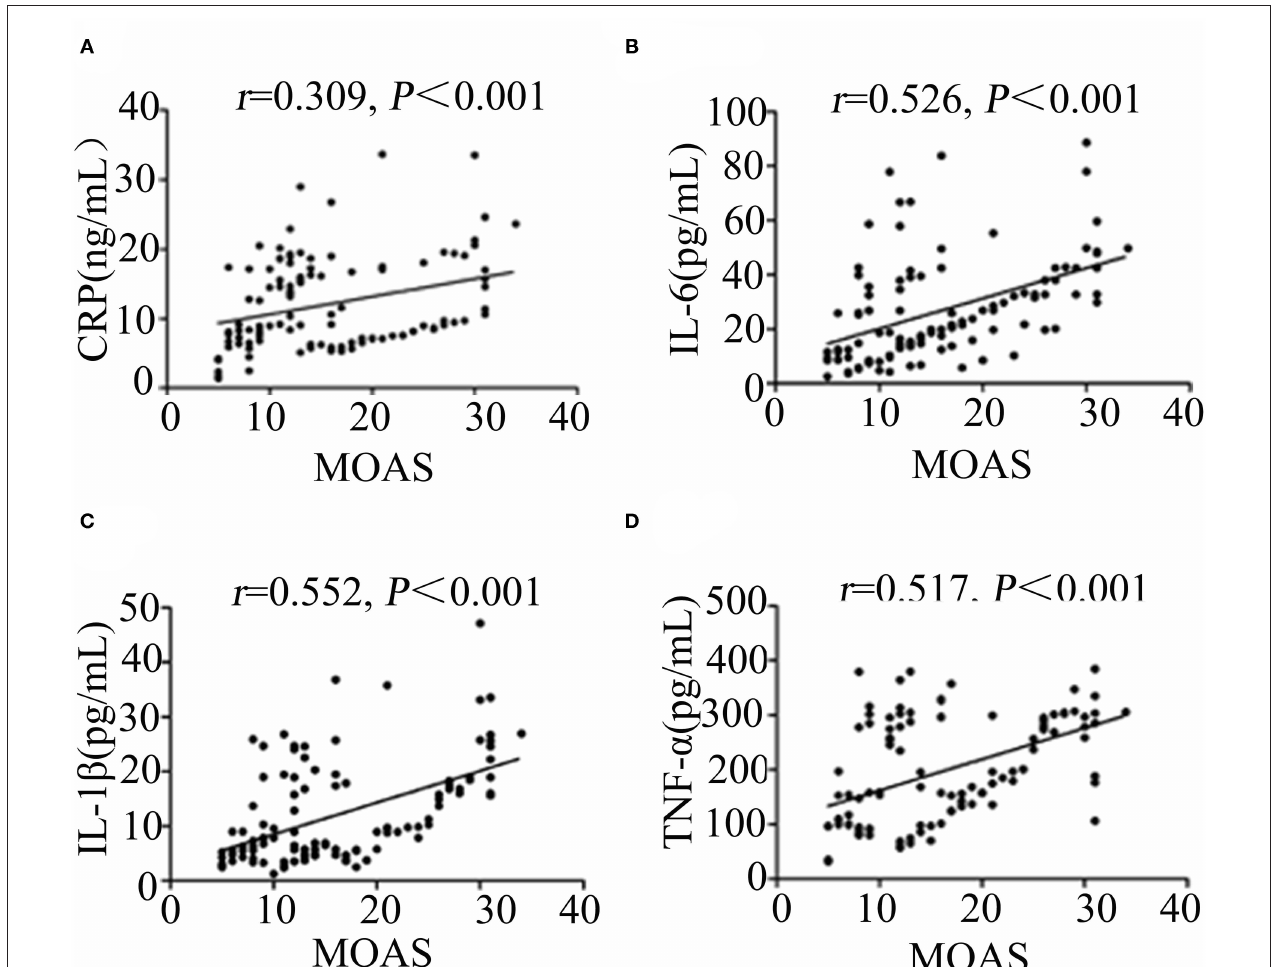
FIGURE 2 | Partial correlation analyses of MOAS with CRP (A) , IL-6 (B) , IL-1 β (C) , and TNF- α (D) in ScZ-Ag